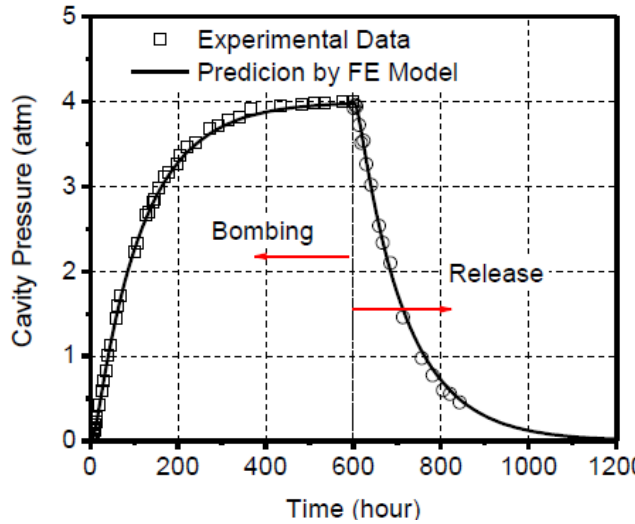
Figure 14. Cavity pressure evolutions measured by the optical leak test are compared with the numerical